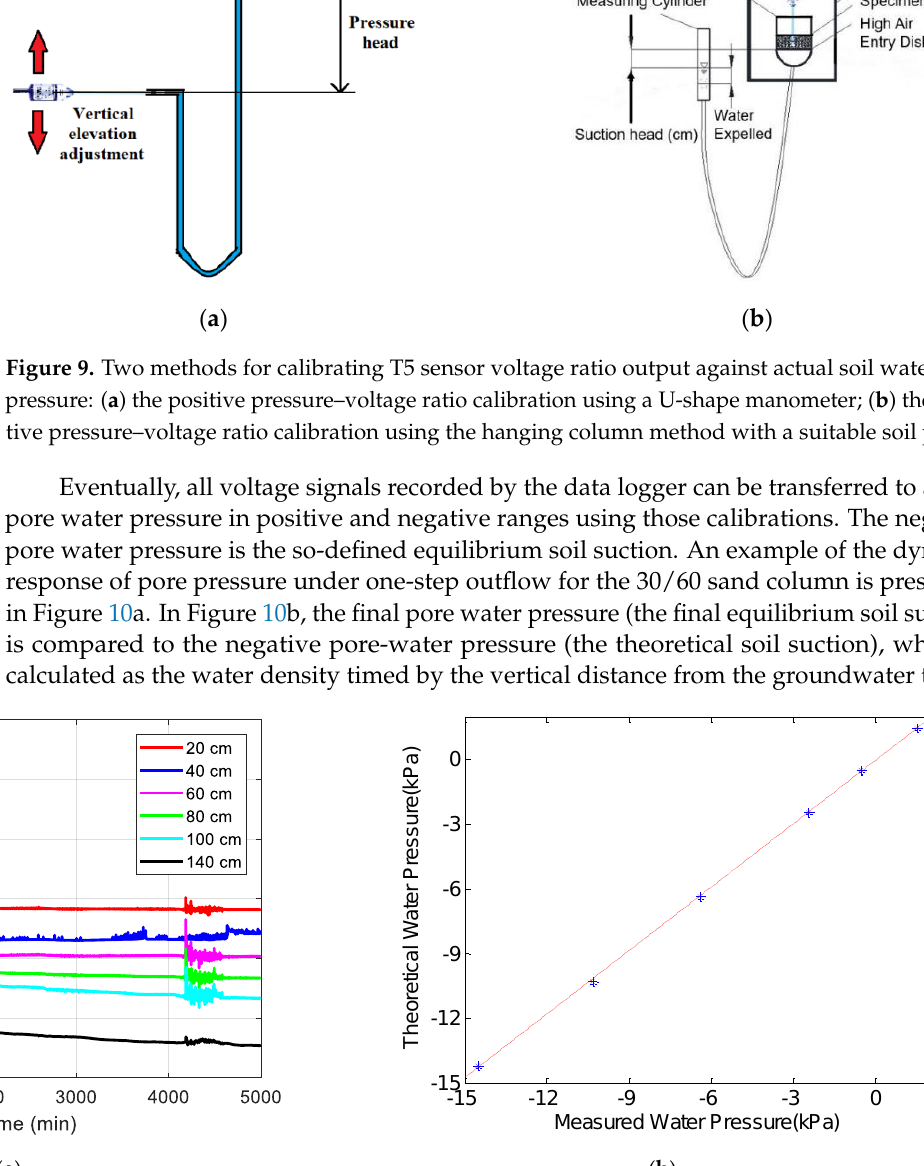
( d ) Figure 8. The connector configuration between the T5 sensor and logger analogue channel and cor- responding signal processing between the voltage in/outputs from the T5 Wheatstone circuit and pore pressure: ( a ) the T5 sensor connector design; ( b ) the analogue channel on GeoLogger compat- ible with the Wheatstone circuit with an additional 3 V power supply; ( c ) the voltage in/outputs of Wheatstone circuit; ( d ) the linear calibration between voltage output and pore pressure [16,65,68]. Figure 8d shows the linear calibration between the output signal (bridge excitation voltage over bridge output voltage, V out /V ex ) and soil pore water pressure. A slope of – 0.0022 could be determined between the voltage ratio and pore pressure with an offset, which has nothing to do with the previously elaborated sensor installation. This offset only matters with the aging membrane in the sensor body. Due to the aging issue, the membrane might not function as elastic as it used to be and therefore falsify the reading with a bias. However, it is possible to measure the pore pressure variation accurately by